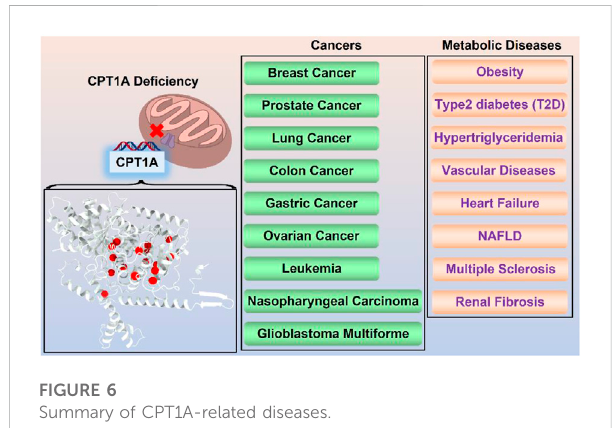
FIGURE 6 Summary of CPT1A-related